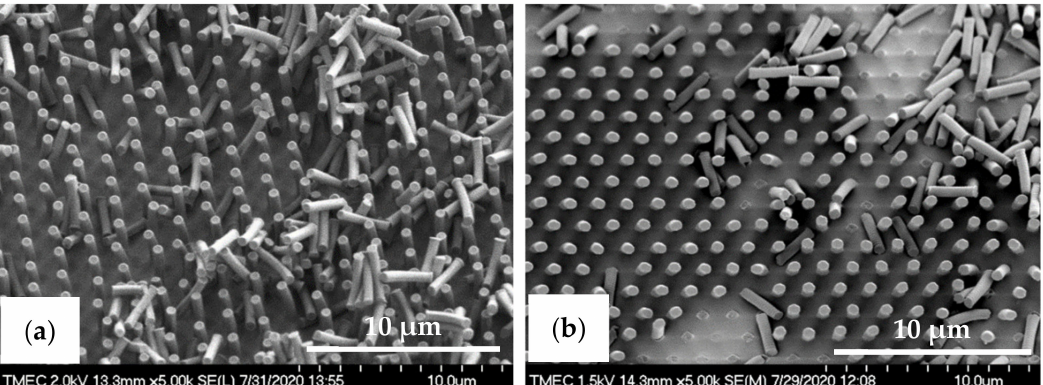
Figure 20. Top-view SEM images of the R2P NIL replicated pillar micro-structure (designed pattern size: diameter: 0.5 µ m, height: 2.5 µ m) after scratch test ( a ) imprint on PC foil with resin A (PIL-A) and ( b ) imprint on PC foil with resin B